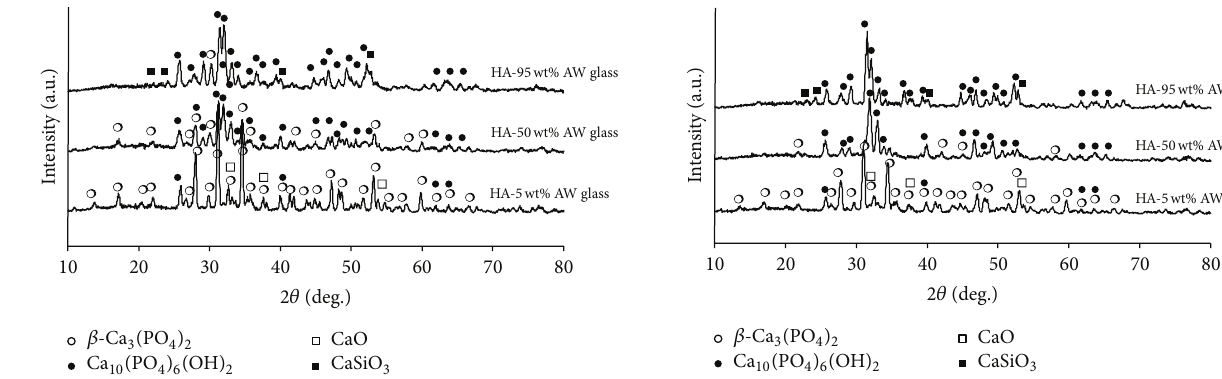
Figure 3: XRD patterns of HA-AW composites sintered at 1100 ∘ C for 2 h.